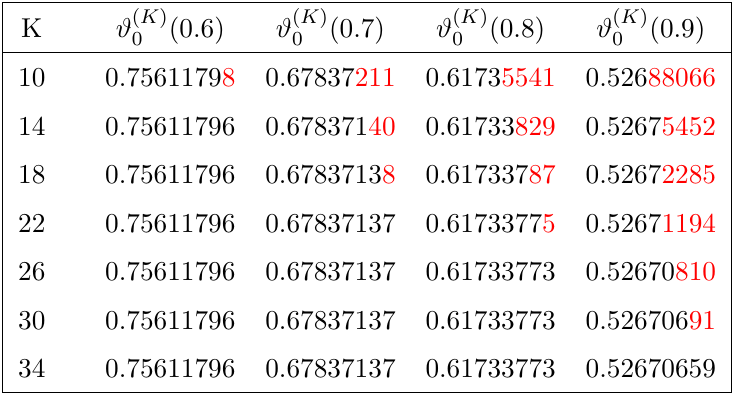
Table 1 . Solution of the condition (2.10) for various x > x H and increasing number of modes K . As a guide, we write in red the digits that change moving to the next